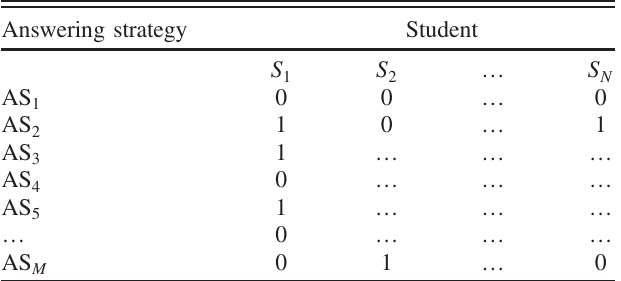
TABLE I. Matrix of the data: the N students and the M answering strategies are denoted as S 1 ; S 2 ; … ; S N ., and as AS 1 ; AS 2 ; … ; AS M ,